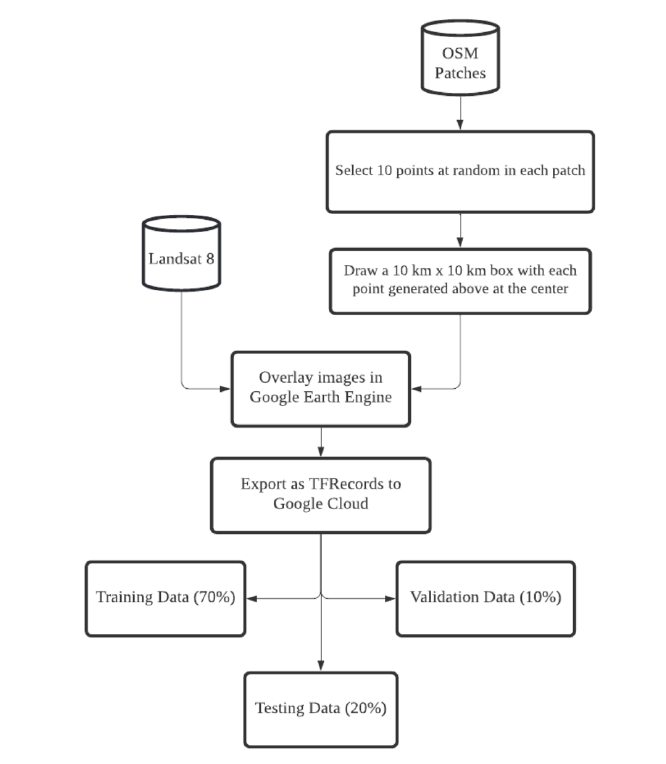
Figure 6. Impervious surfaces labeled data